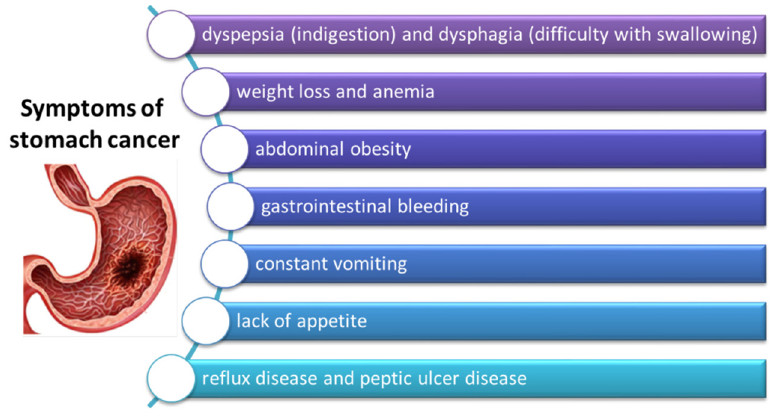
Figure 5. Symptoms of gastric cancer (based on [79]).